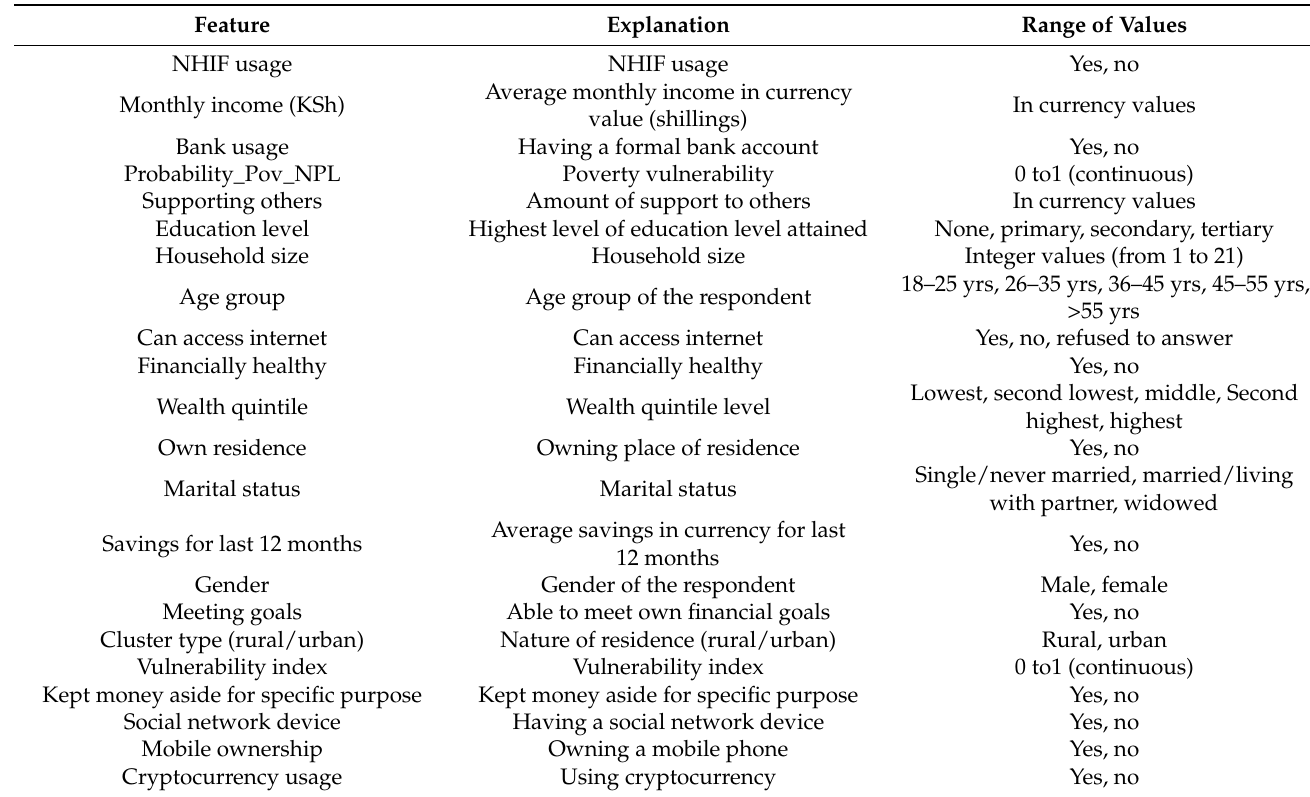
Table A6. Description of